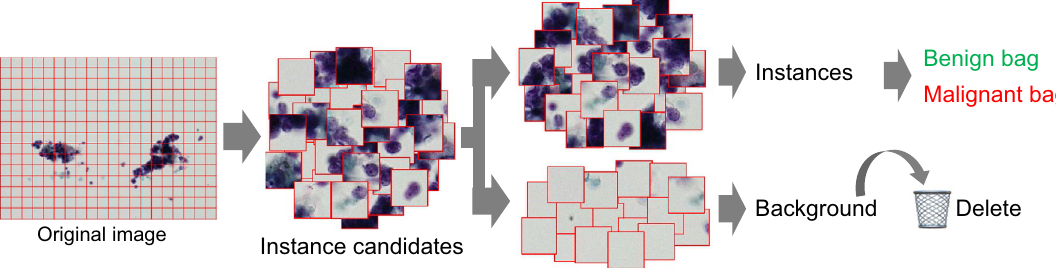
Figure 2. Generation of instances for benign and malignant